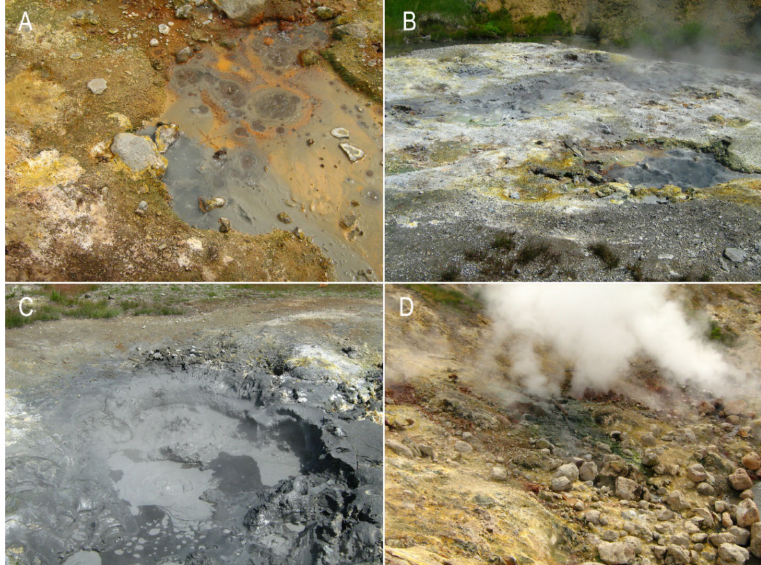
Figure 2. Studysites: ( A )—K1,theRiverKluchevkabank,thespringvent(area1); ( B )—K2,theVillageMalki, hot spring vent (area 1); ( C )—K7, small geysers on the plateau on Mutnovski volcano valley, fumaroles, and small boiling mud pool (area 3); ( D )—K8, small geysers on the plateau near Mutnovski volcano (area 3). For the comparison and visualization of the similarities between diatom communities from the Malki, Upper Paratunka, and Dachnie thermal springs, we used a Venn diagram [49,50]. The Venn diagram was created using the web-based InteractiVenn tool